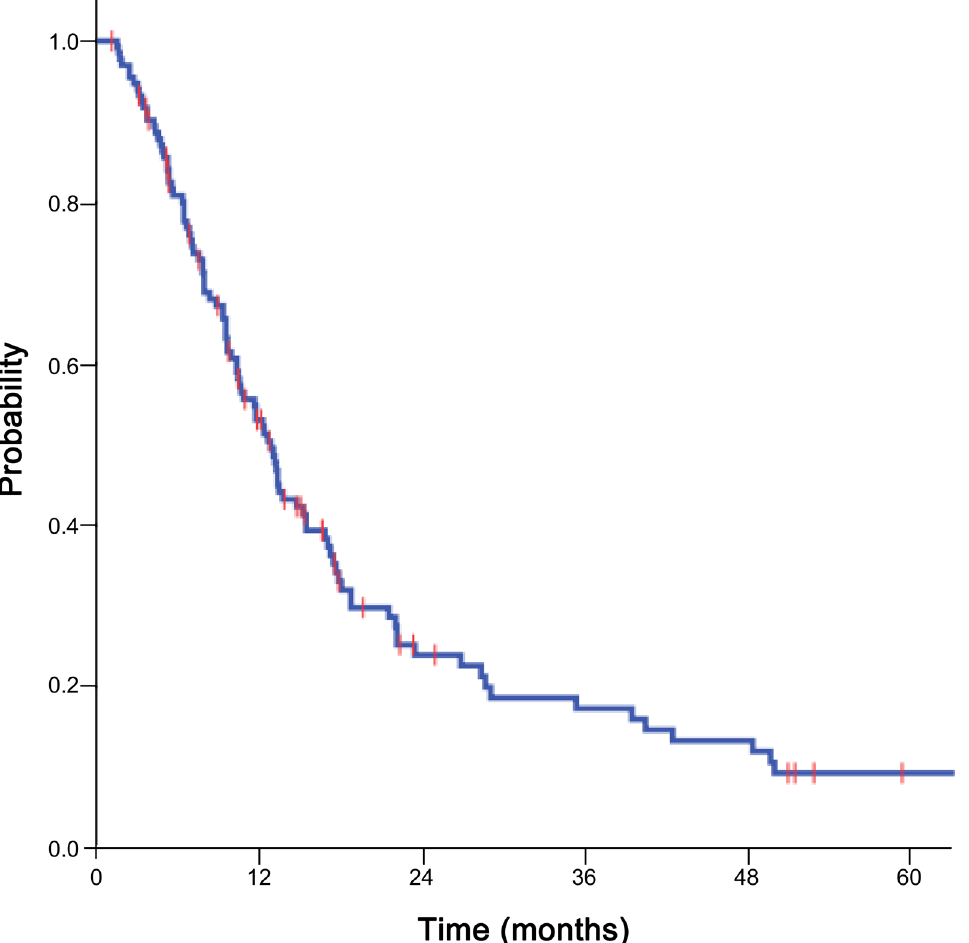
Fig 1. Overall survival curve. Overall survival curve for patients with adrenal metastasis from hepatocellular carcinoma receiving radiotherapy.